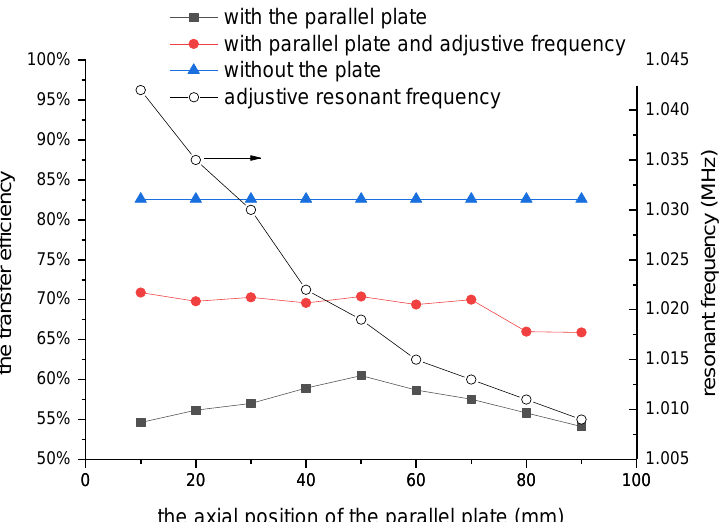
Figure 11. Experimental results of the variation of the efficiency with the axial position of the parallel plates.